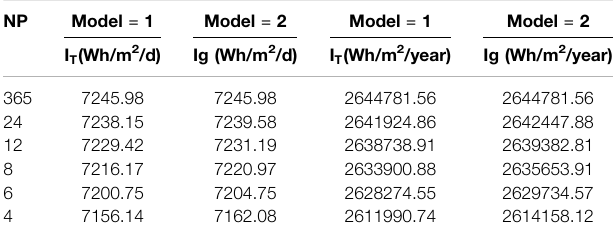
TABLE 6 | Results comparison.